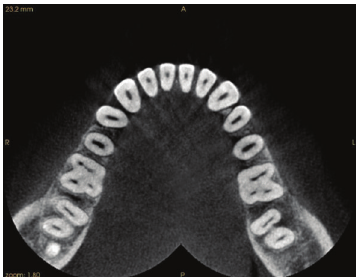
Figure 5: Axial views allow the relationship between the additional root and other roots to be assessed.